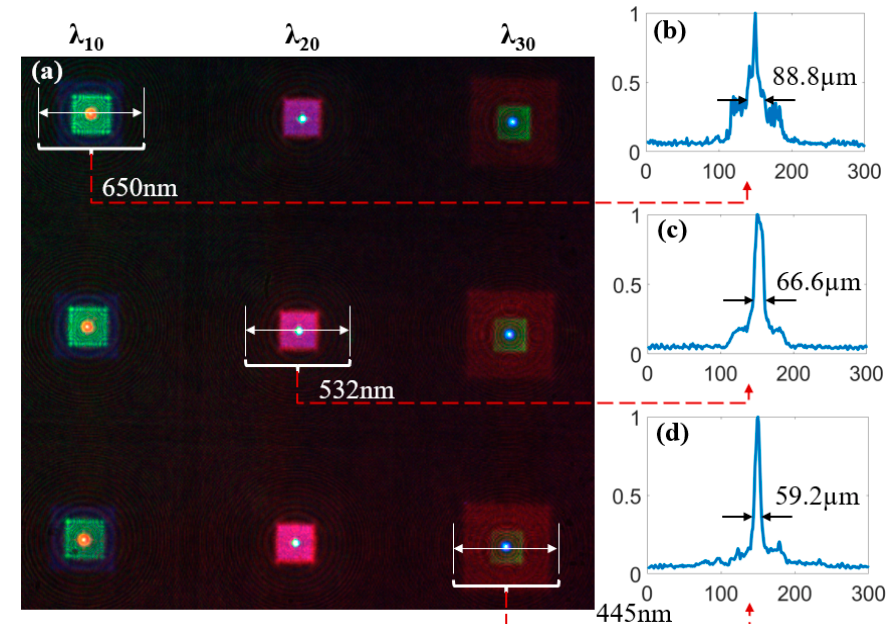
Figure 7. Distributions of the focal spots: ( a ) distributions of focal spots when red, green and blue lasers simultaneously irradiate the multi-spectral compound eye structure; ( b ) the intensity distribution of the focal spot at a wavelength of 650 nm; ( c ) the intensity distribution of the focal spot at a wavelength of 532 nm; ( d ) the intensity distribution of the focal spot at a wavelength of 445 nm. Under the same focal length and aperture, the longer the wavelength is, the larger the focal spot size is. The experimental results are in agreement with the theory. Therefore, with the increase of focal spot size, the imaging quality will become worse. In addition, because the scattered spots of other wavelengths are superimposed on the focal spots, the sizes of the captured focal spots which affects the imaging quality are larger than that of the theoretical Airy spots. From the energy distribution curve, it can be seen that, for the focal spot of red light, the intensity of the diffuse spots produced by other wavelengths is larger than the other colors. This is also the reason for the poor effect of red image in the later imaging